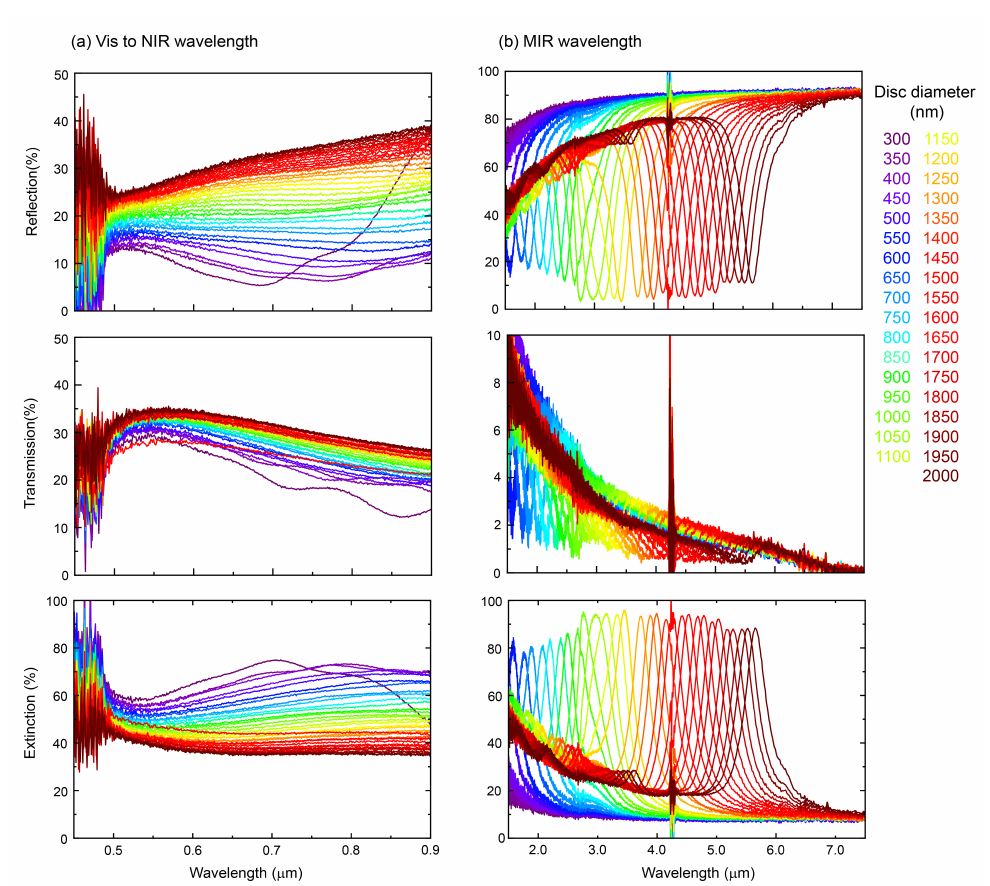
Figure 2. Experimental spectra. Optical reflection, transmission, and extinction spectra of thin-Au metasurfaces (Figure 1b) from visible to MIR wavelengths. ( a ) Visible to near infrared wavelength, ( b ) MIR wavelength. Thicknesses of layers in the MIM structure: Au-disc of 50 nm, SiO 2 of 100 nm, and Au film of 10 nm (with a 2 nm of Cr adhesion layer); substrate was 0.3 mm sapphire. The period- to-diameter ratio was two. A spectrally narrow anti-reflective band ( R → 0) at IR wavelengths with simultaneous low transmission ( T → 0) marks the position of strong absorption (an expected strong thermal emission for radiative